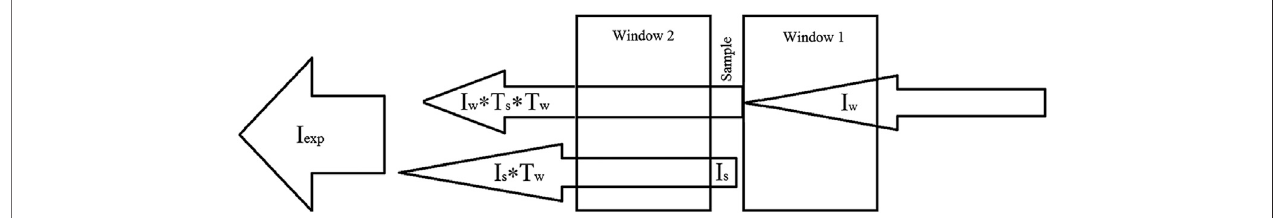
FIGURE 1 | Illustration of emission fl uxes in the measurement system clarifying corrective transformation Eq. 1 .